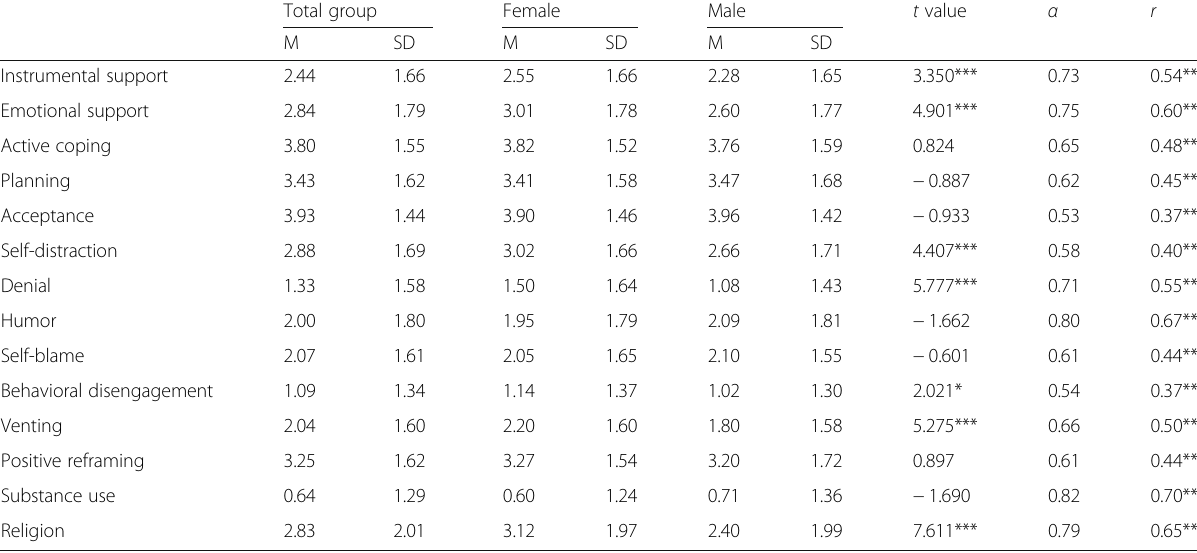
Table 5 Descriptive statistics for total group ( n = 1847) and for gender (female = 115; male = 732), Cronbach ’ s alpha, and Pearson ’ s r correlation